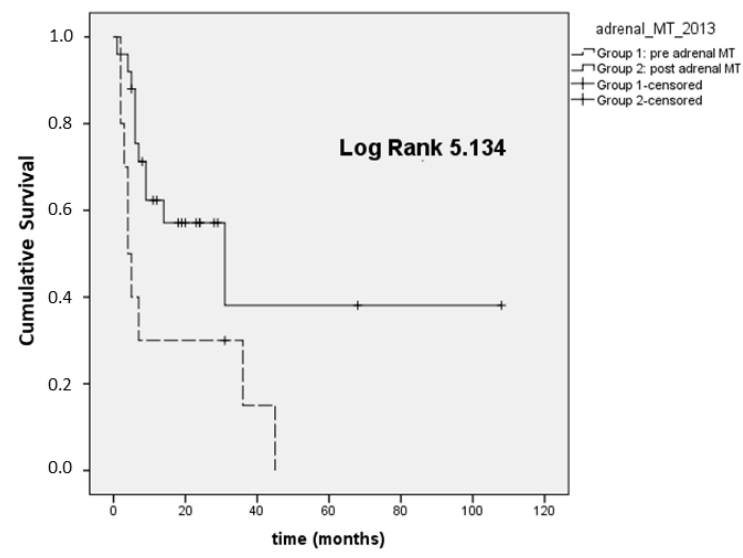
Figure 2. Overall survival first visit-last FU (OS first visit-last FU ) in ACC stage III–IV. Regarding PFS, we observed a median PFS first treatment in Group 1 of 2.9 months (95% CI 0–6.1), compared to a median PFS first treatment of 17.2 months (95% CI 3–31.4) in Group 2 ( p < 0.001). The median PFS first treatment was 2.9 months (95% CI 1.5–4.2) in Group 1 stage III-IV and 8.7 months (95% CI 2.3–15, p = 0.02) in Group 2 stage III-IV (Figure 3).